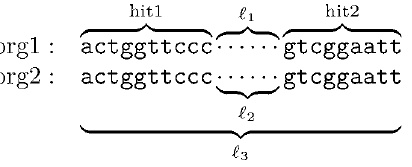
Figure 6. Parameters Considered When Stitching Hits Having the Same Orientation (Step 4 of the Preprocessing Phase) To stitch the hits hit1 and hit2, we consider first the distance between them in both organisms (length ‘ 1 and ‘ 2 , respectively). If the segments corresponding to the lengths ‘ 1 and ‘ 2 are similar, then ‘ 1 and ‘ 2 are expected to have similar values. Assuming the latter, the difference between the distances of the two hits, i.e., j ‘ 1 (cid:1) ‘ 2 j , should be small. In addition, consecutive hits in similar segments are expected to be close, i.e., both distances, ‘ 1 and ‘ 2 , should be small. Finally, if hit1 and hit2 are stitched (with no other hits stitched to them), we check that the total segment’s length in each organism is long enough. In org2 this length is referred to as ‘ 3 . DOI: